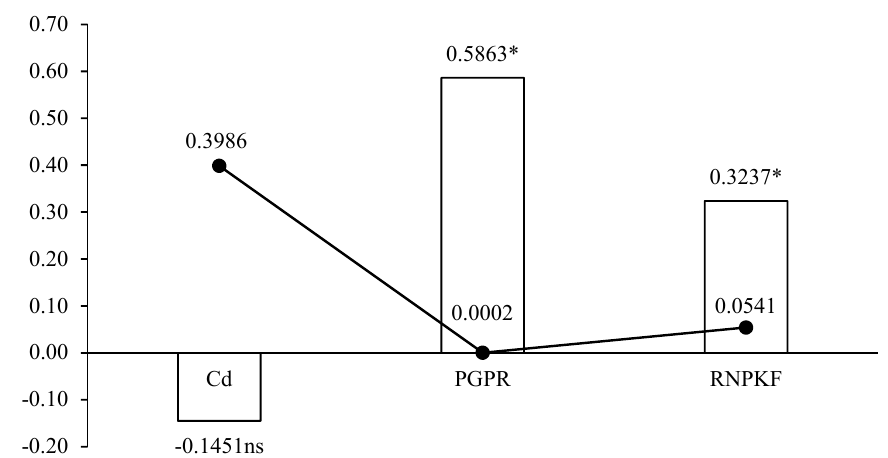
Figure 3. Pearson correlation of Cd, PGPRs, and RNPKF for number of bitter gourd per plant (BDP). * = significant ( p ≤ 0.05); ns = non ‐ significant.